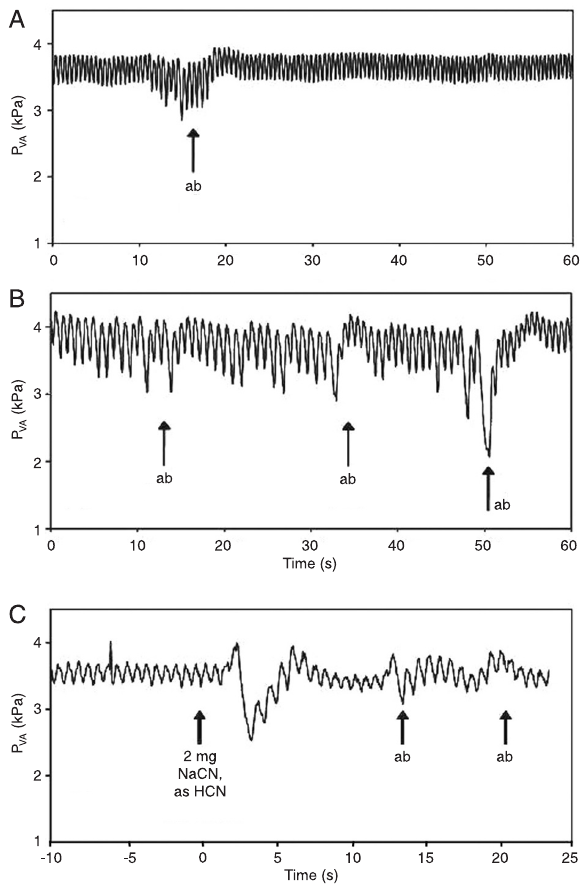
Figure 6. Representative traces of ventral aortic blood pressure (P VA ) in a giant mudskipper ( Periopthalmodon schlosseri , body mass 142 g) in normoxia (A), aerial hypoxia at 5% of normal at - mospheric O 2 saturation (B), and in response to a bolus injection of 2 mg NaCN (acidified to form gaseous HCN) given as a bolus into the orobranchial cavity during an air-breath holding period (C), see text for details. ab, air-breath, confirmed visually, with the typical variations in heart rate associated with exhalation and inhalation. In this animal, air-breathing frequency was 7/h in nor - moxia and rose to 85/h in aerial